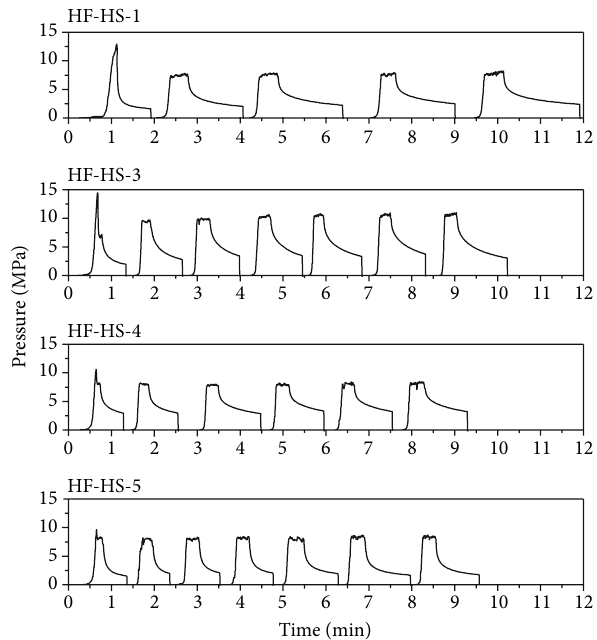
Figure 6: Pressure vs. time in the HF tests in the case of red